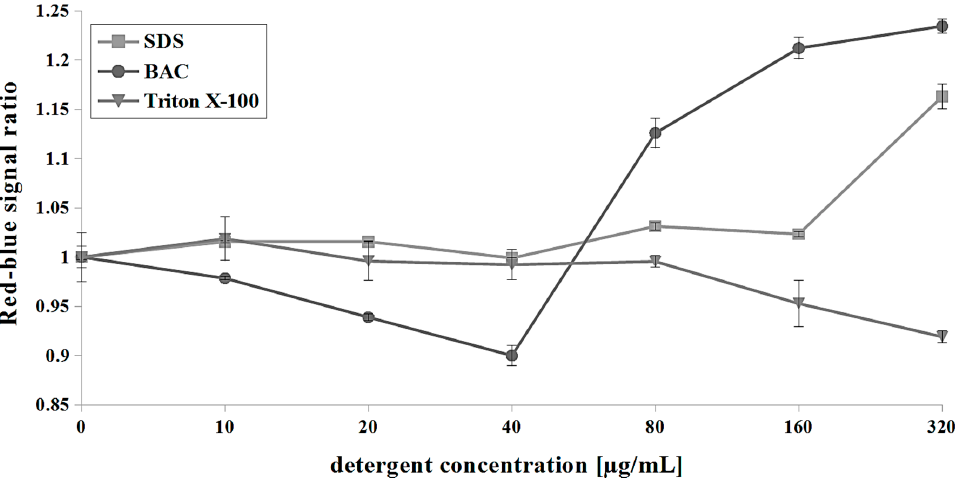
Figure 4. The influence of detergents sodium dodecyl sulfate (SDS) (0–320 µg/mL), benzalkonium chloride (BAC) (0–320 µg/mL) and Triton X-100 (0–320 µg/mL) on Δ ѱ . For data analysis, red-blue